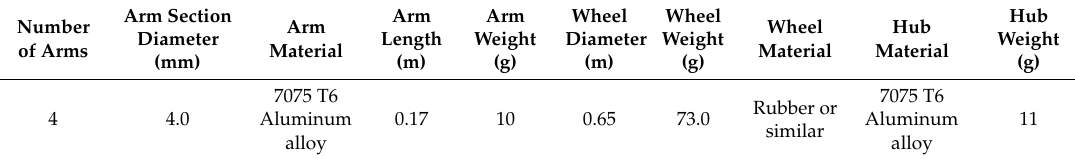
Table 3. Characteristics of deployment and blocking